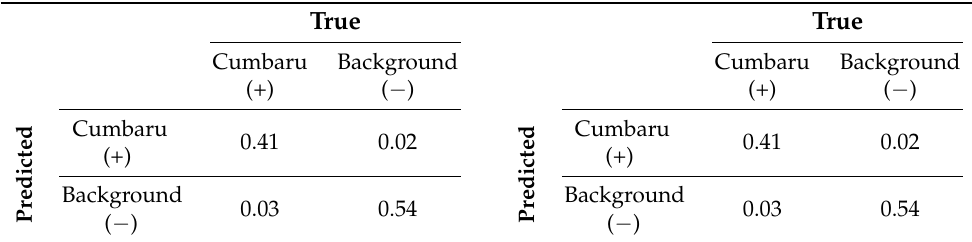
Table A5. Confusion matrix for the DeepLabv3+ MobileNetV2 version without CRF (left) and with CRF (right). The values are normalized by the total of